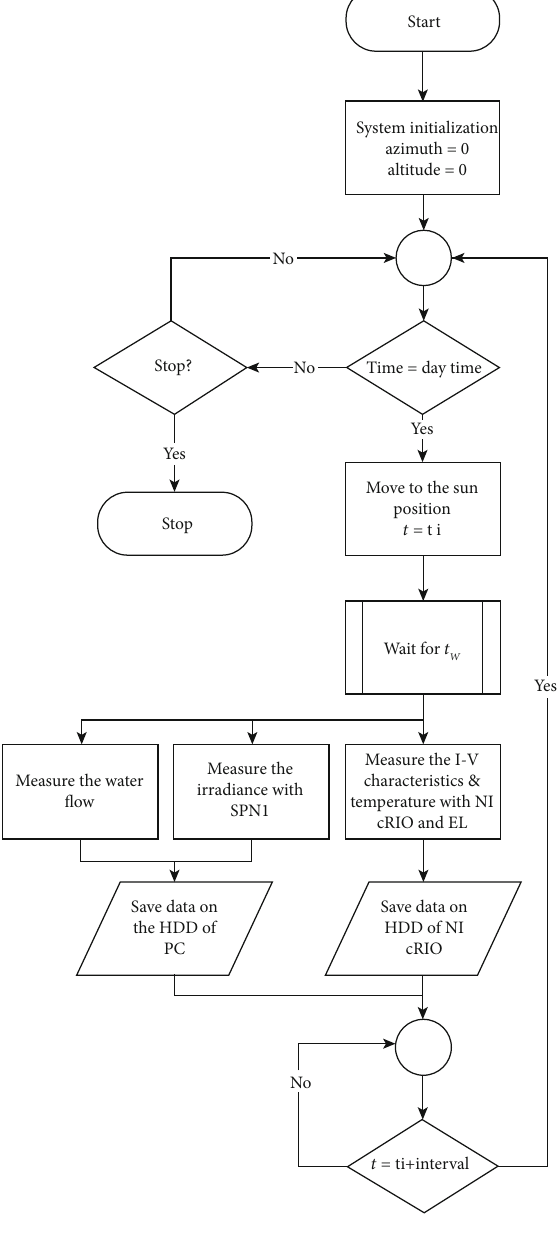
Figure 4: The fl ow chart of the system operation and